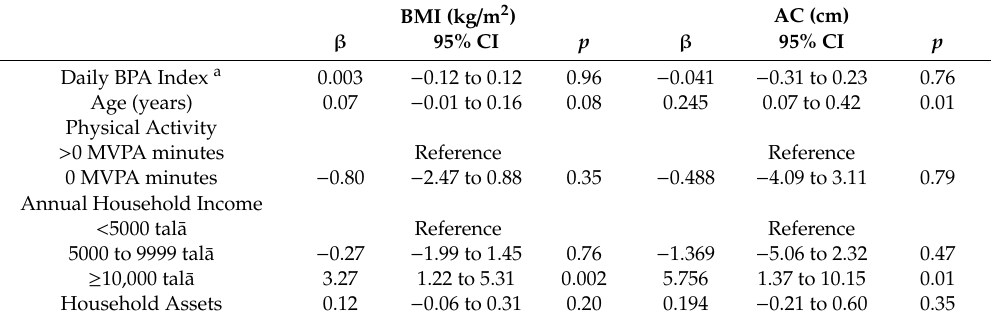
Table 5. Results of multiple linear regression examining associations between daily BPA index and body mass index and abdominal circumference in mothers ( n = 346) while adjusting for